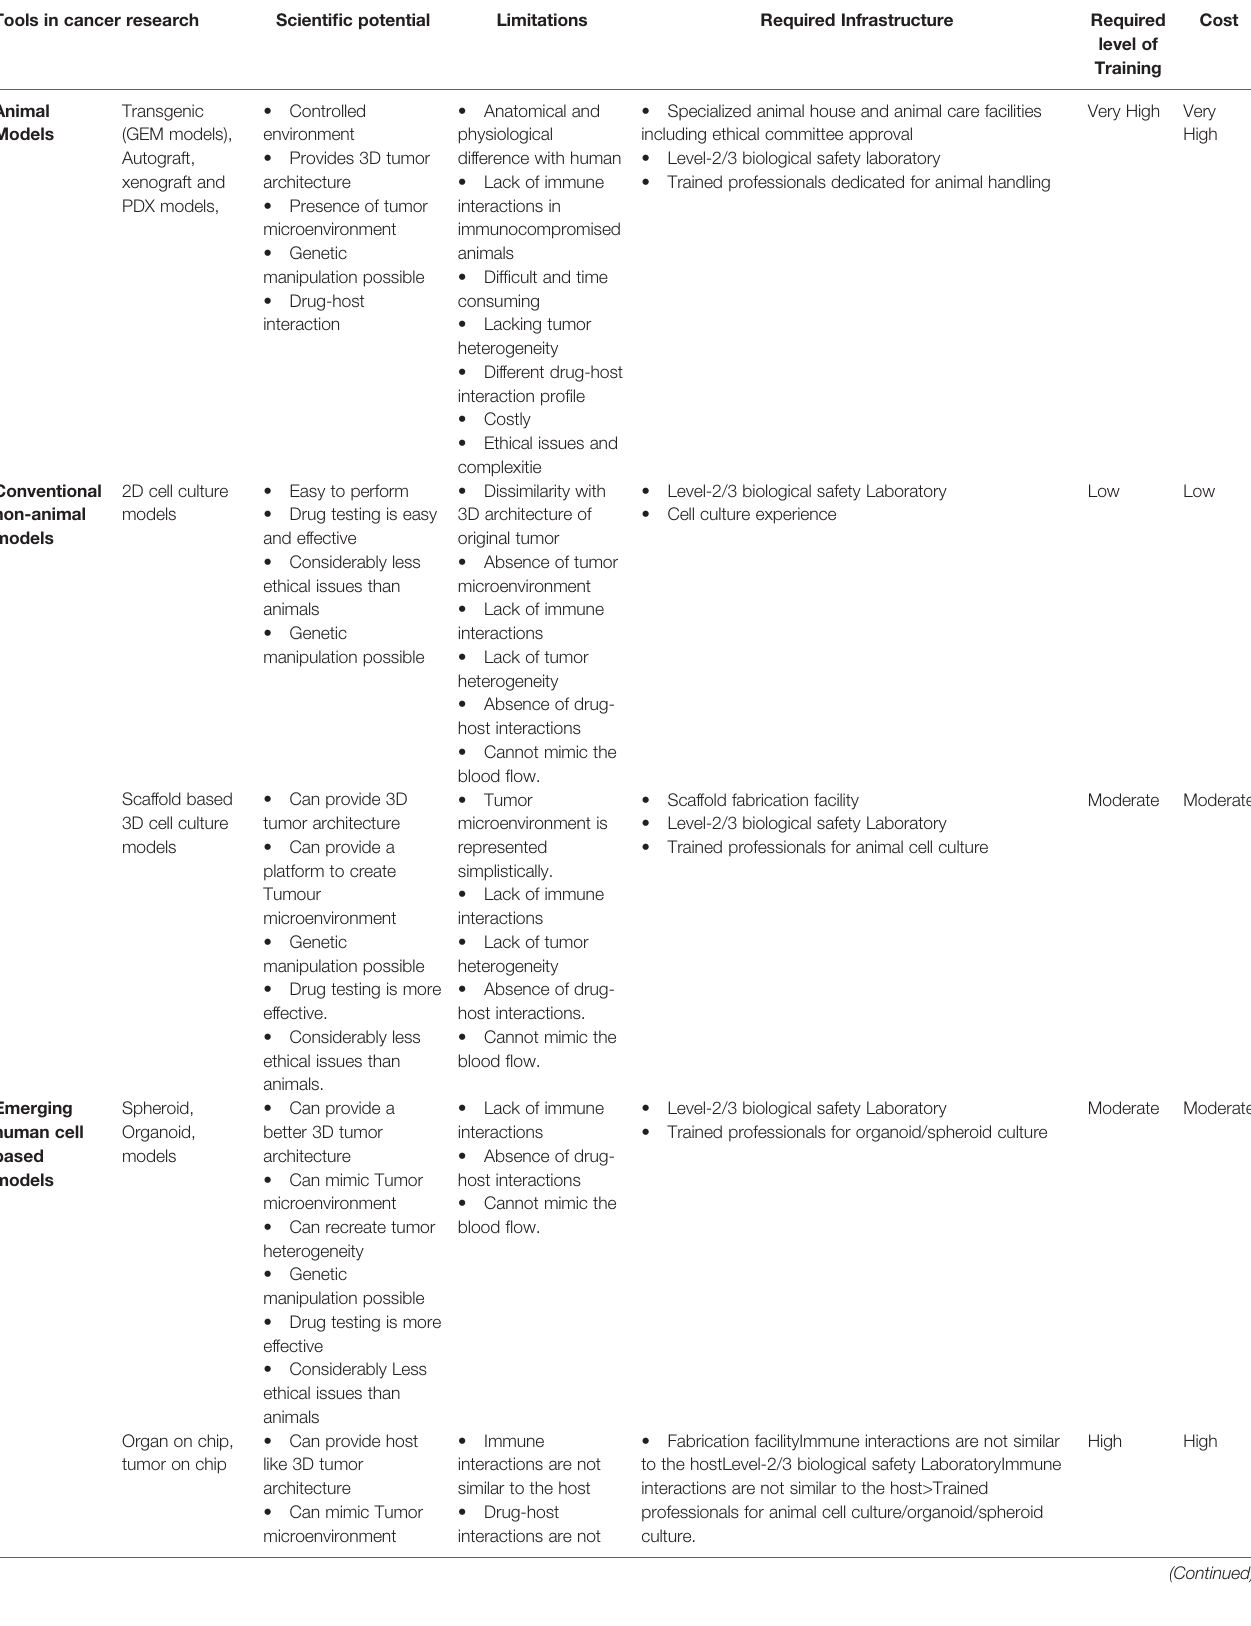
TABLE 3 | Potential and limitations of different cancer research models (including in vitro , in vivo and in silico models). Tools in cancer